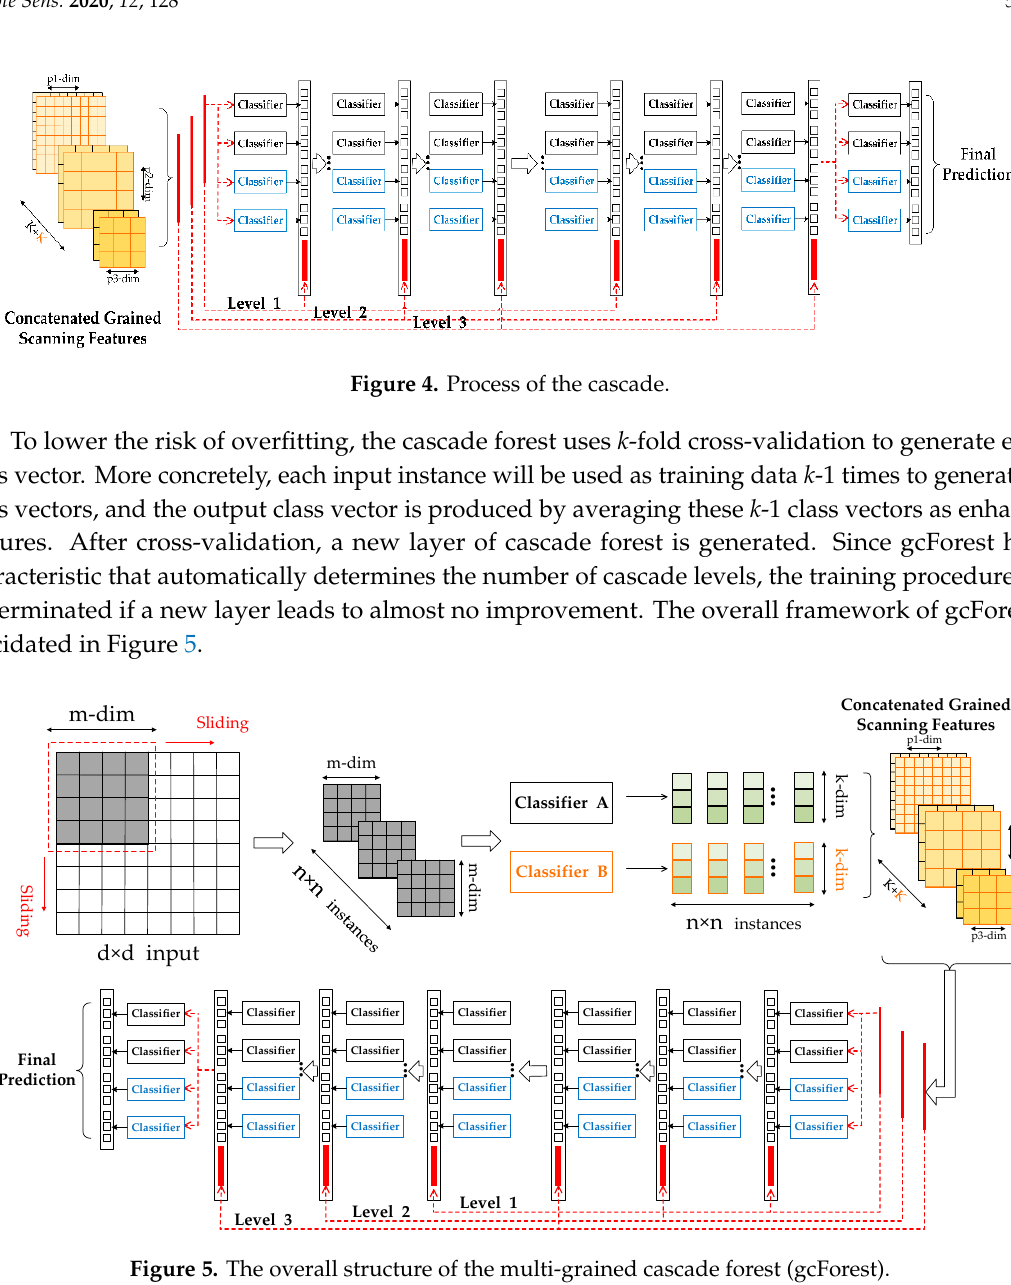
Figure 5. The overall structure of the multi-grained cascade forest (gcForest).